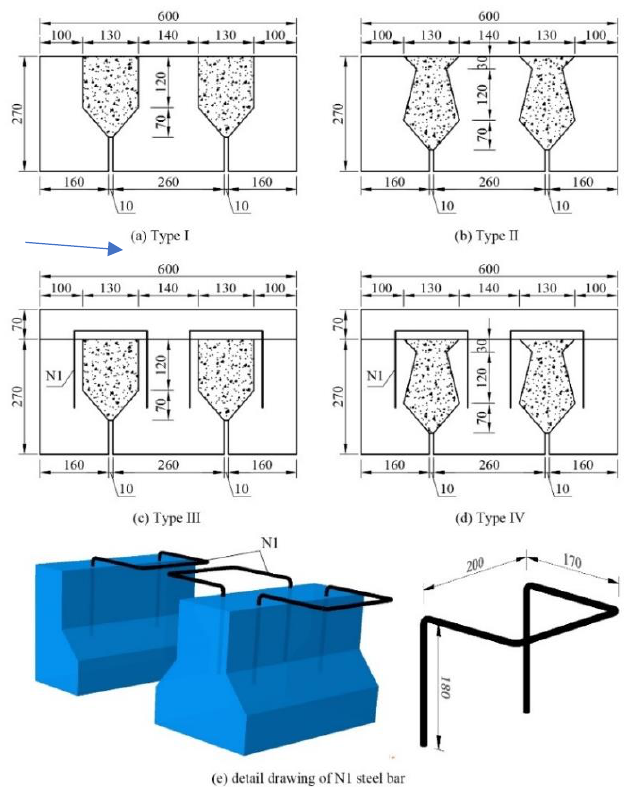
Figure 1. Configuration of specimens (note: all dimensions in mm): ( a ) Type I; ( b ) Type II; ( c ) Type III; ( d ) Type IV; ( e ) detail drawing of N1 steel